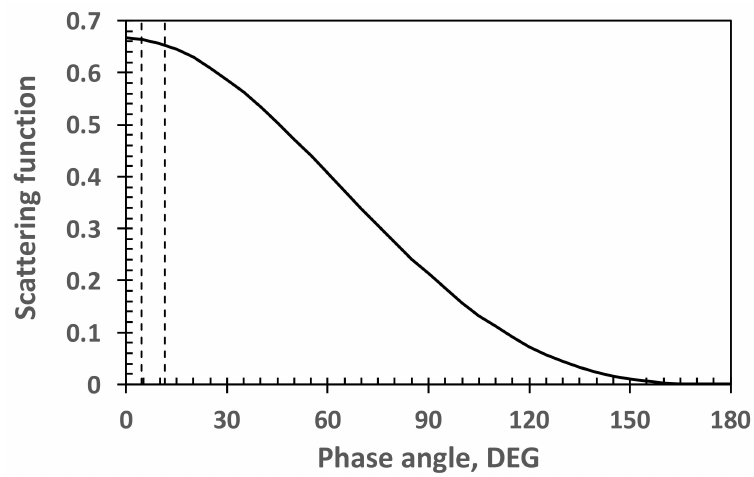
Figure 2. Scattering function of an ideal Lambertian sphere ( ρ λ = 1). The two dashed lines illustrate the variation range of the EPIC phase